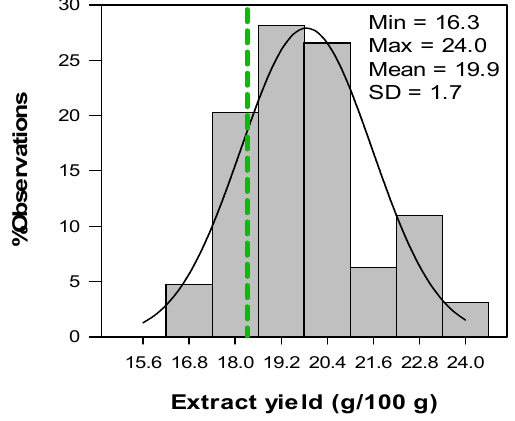
Figure 5. Distribution of the aqueous extract yield obtained for green Cyclopia subternata (n = 64) [dotted green line indicates the 20%